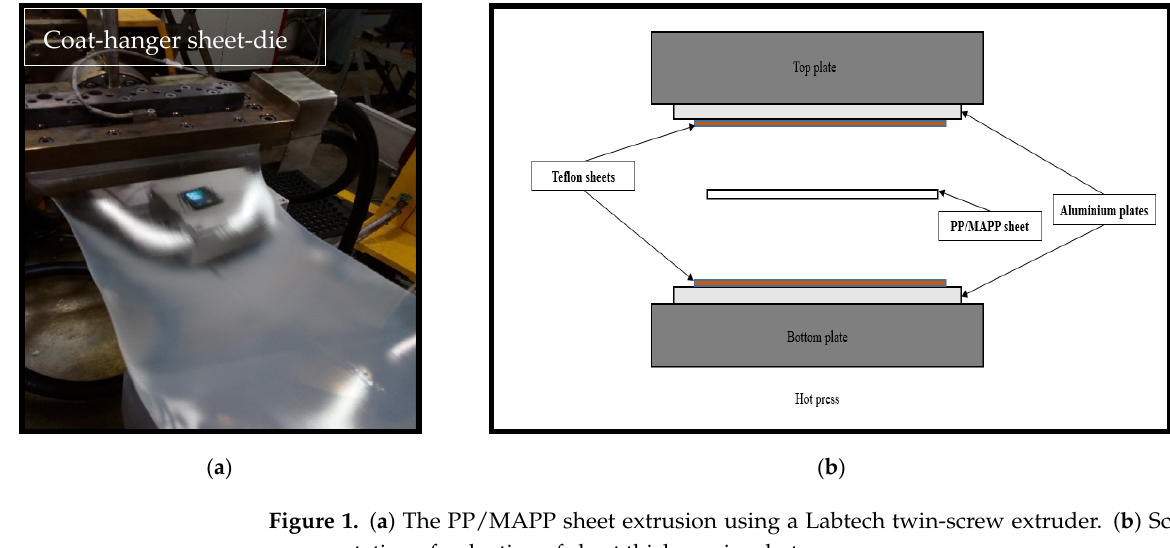
Figure 1. ( a ) The PP/MAPP sheet extrusion using a Labtech twin-screw extruder. ( b ) Schematic representation of reduction of sheet thickness in a hot press.